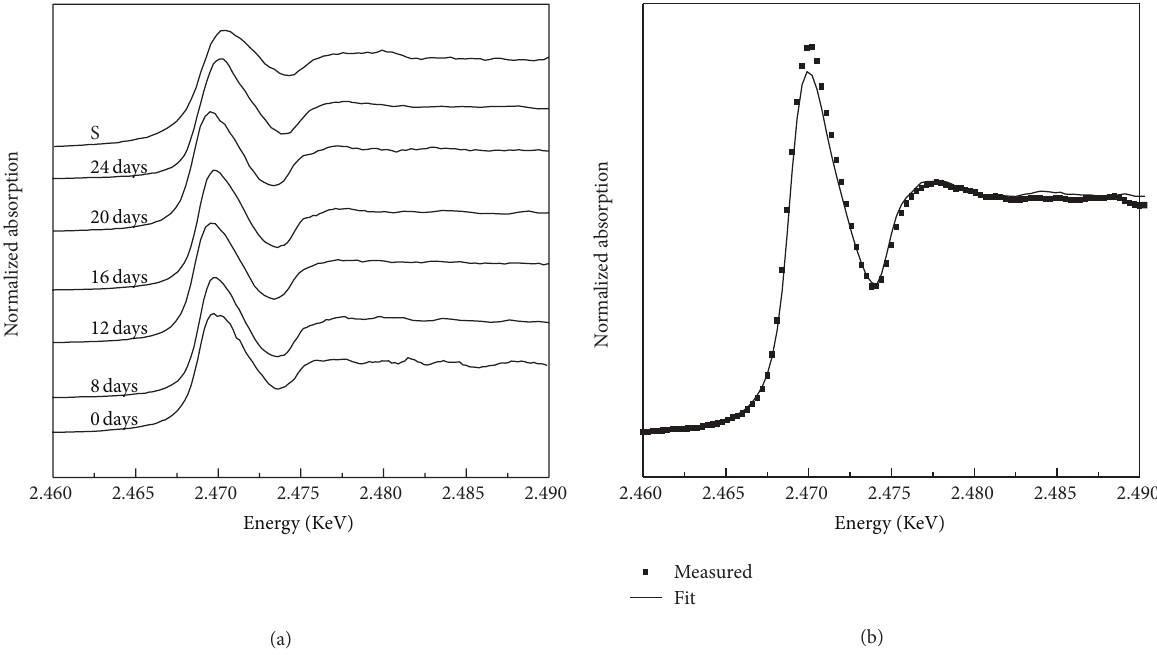
Figure 6: Normalized sulfur K-edge XANES spectra of pyrite leaching with A.